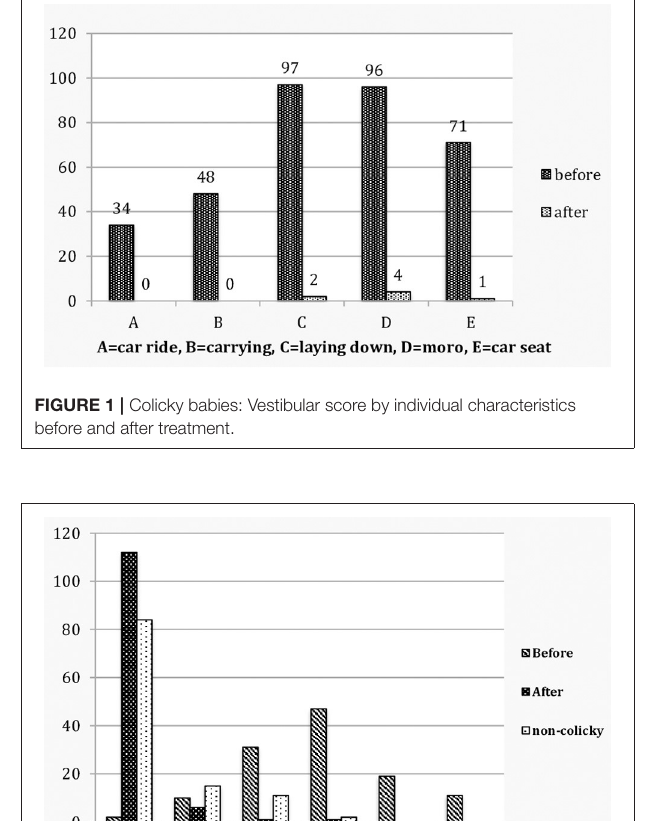
As controls 117 non-colicky, happy babies [mean age